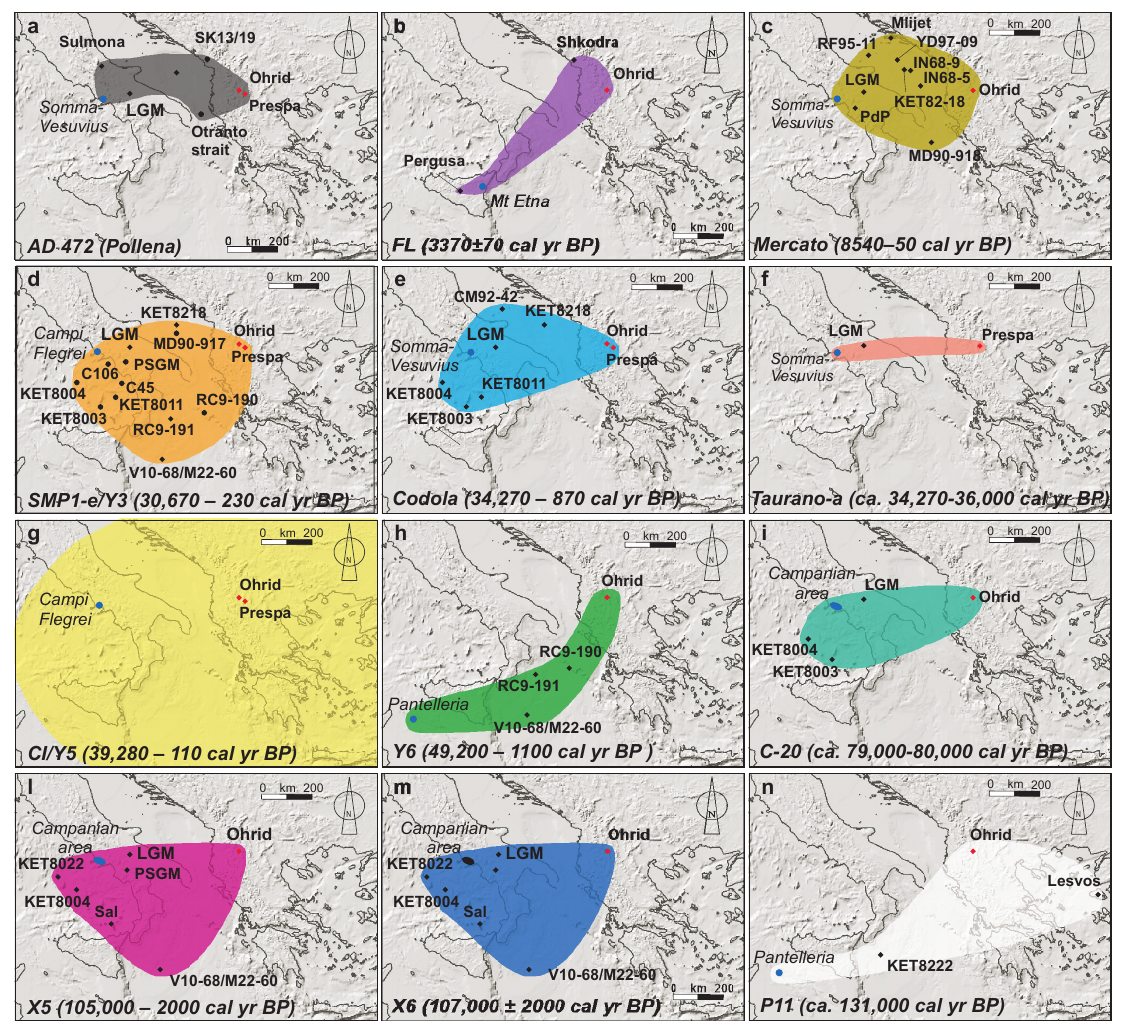
Fig. 8. Dispersal maps of the twelve tephra layers recognised in lakes Ohrid and